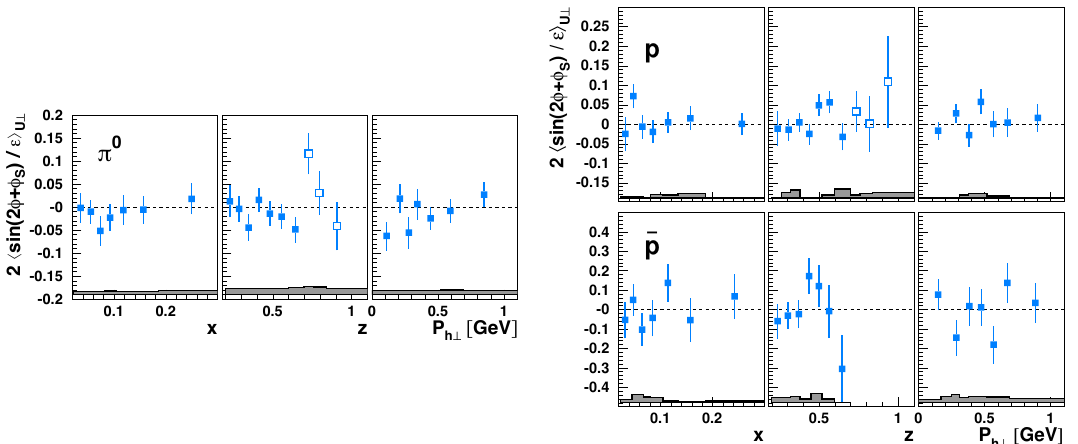
Figure 34 . The 2 h sin(2 φ + φ S ) /(cid:15) i h amplitudes for π 0 (left), protons, and antiprotons (right) U ⊥ presented either in bins of x , z , or P h ⊥ . Data at large values of z , marked by open points in the z projection, are not included in the other projections (no such high- z points are available for an- tiprotons due to a lack of precision). Systematic uncertainties are given as bands, not including the additional scale uncertainty of 7.3% due to the precision of the target-polarization